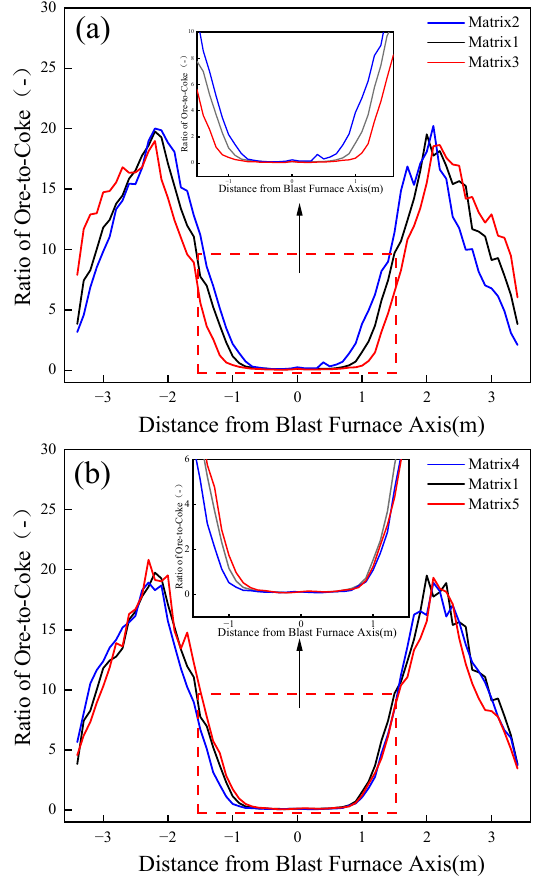
Figure 21. Effect of the distribution angle on the ore-to-coke ratio within the ore-free zone: ( a ) only changing the ore angle; ( b ) changing both the coke and ore angles.